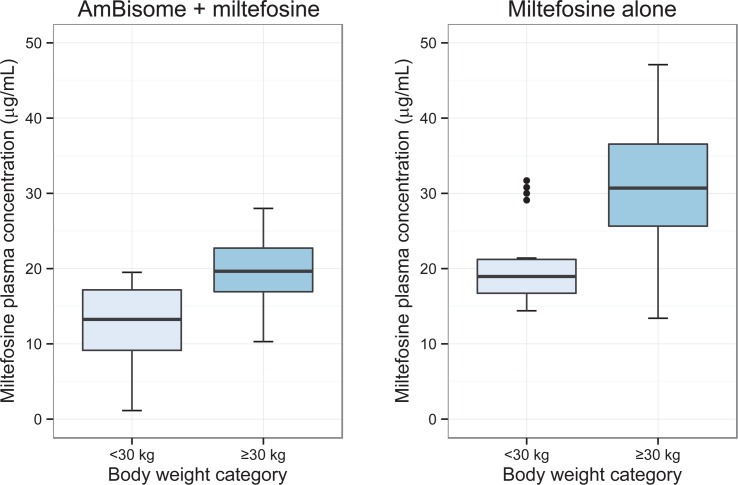
Comparison of the end-of-treatment miltefosine plasma concentrations between body weight categories.The left plot shows the AmBisome + miltefosine arm (10 days of miltefosine), the right plot the miltefosine alone arm (28 days of miltefosine).